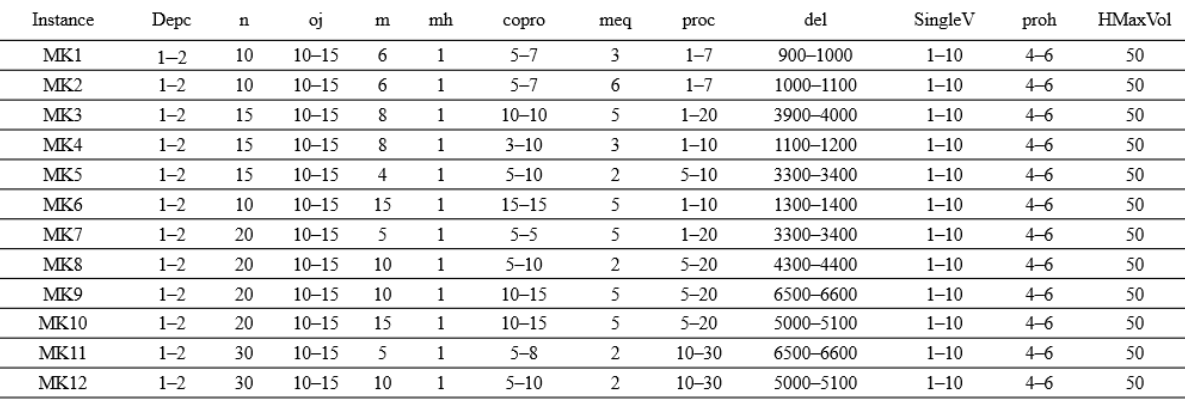
Figure 7. Instance Data.